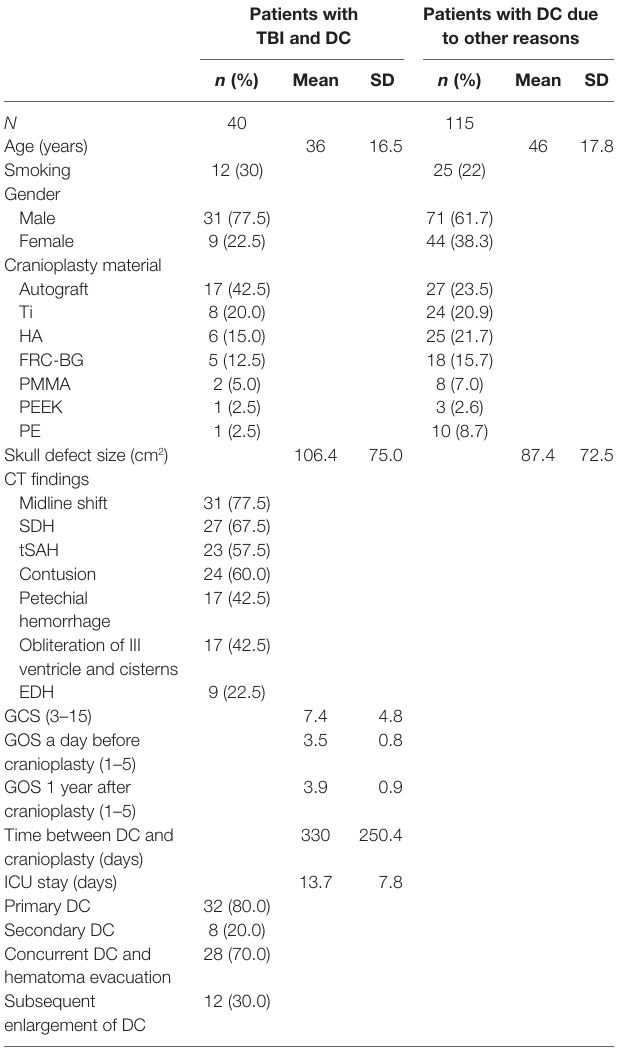
TaBle 1 | Descriptive